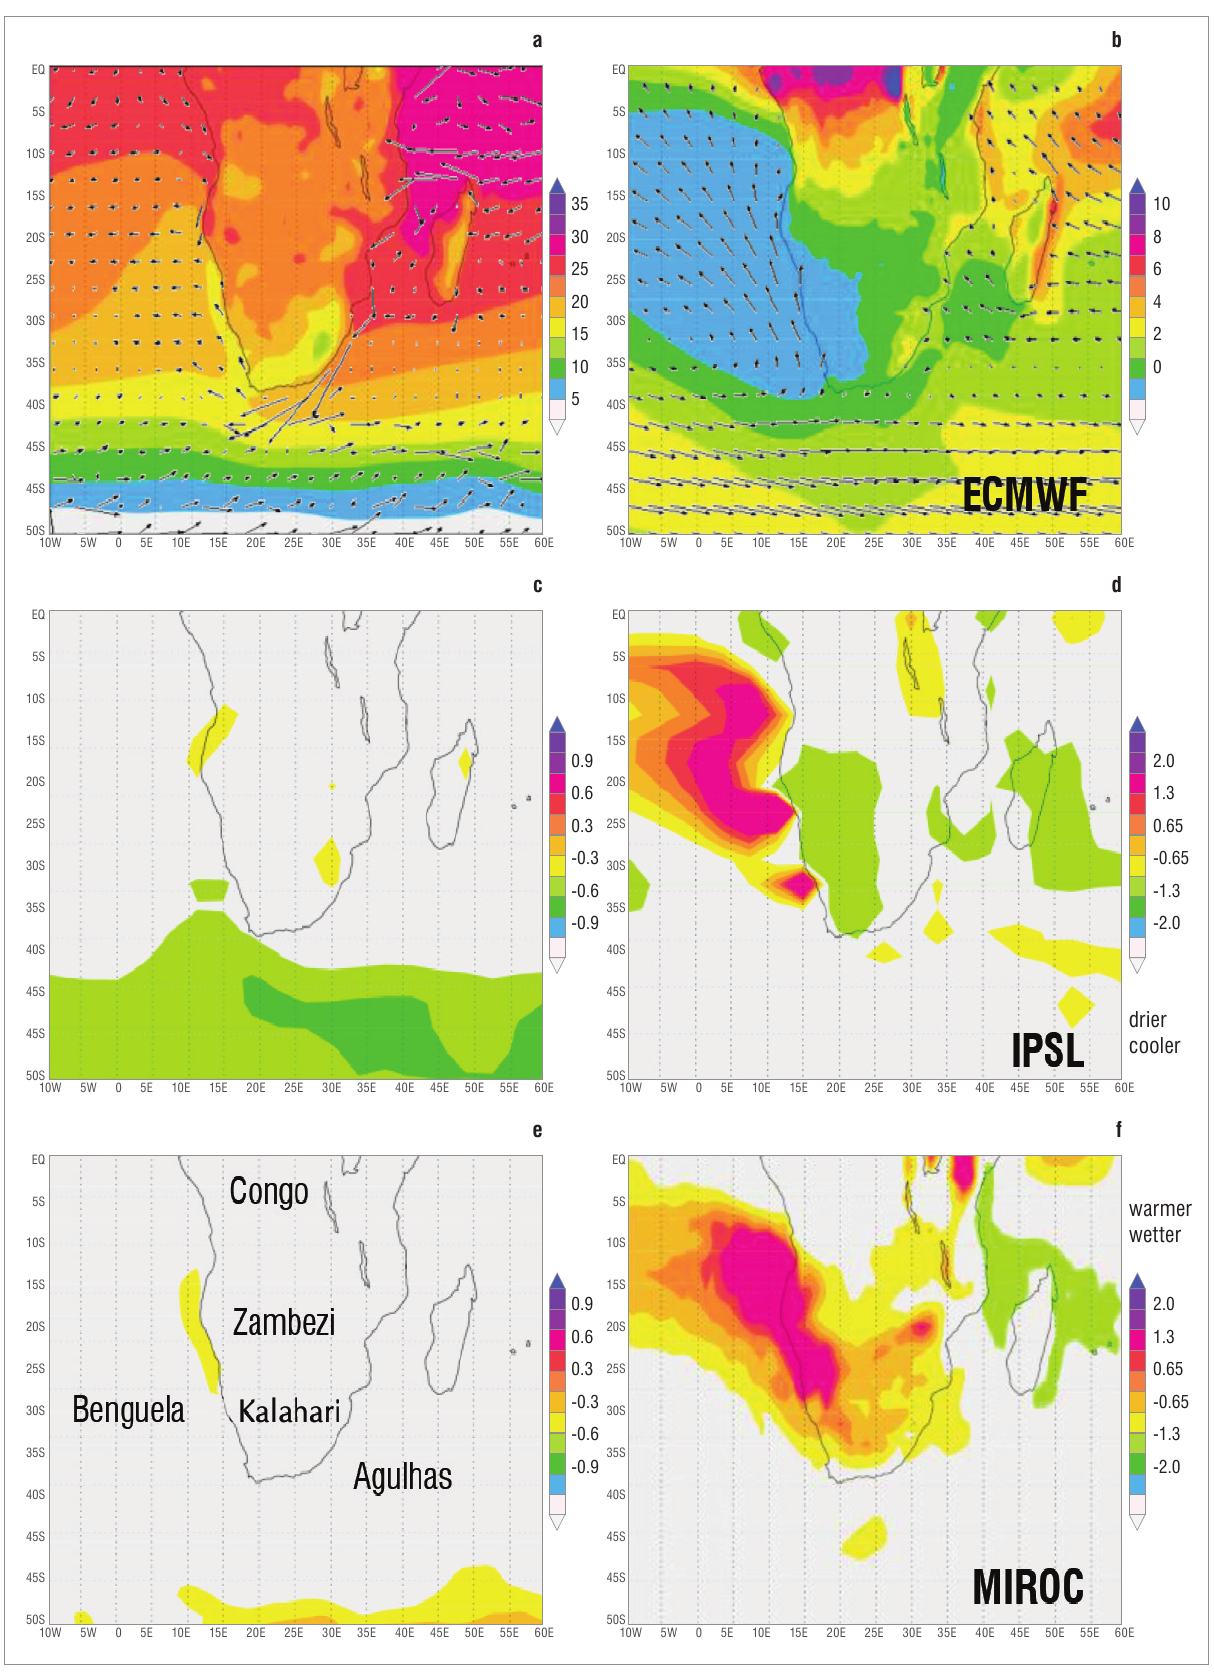
Figure 1: ECMWF climatology for (a) temperature (°C) and (b) rainfall (mm/day) and difference in IPSL (c) temperature and (d) rainfall and MIROC A1B (e) temperature and (f) rainfall simulations for 1980–2010. Vectors for SODA surface currents are included in (a) and ECMWF wind stress in (b). (e) Key places mentioned in the